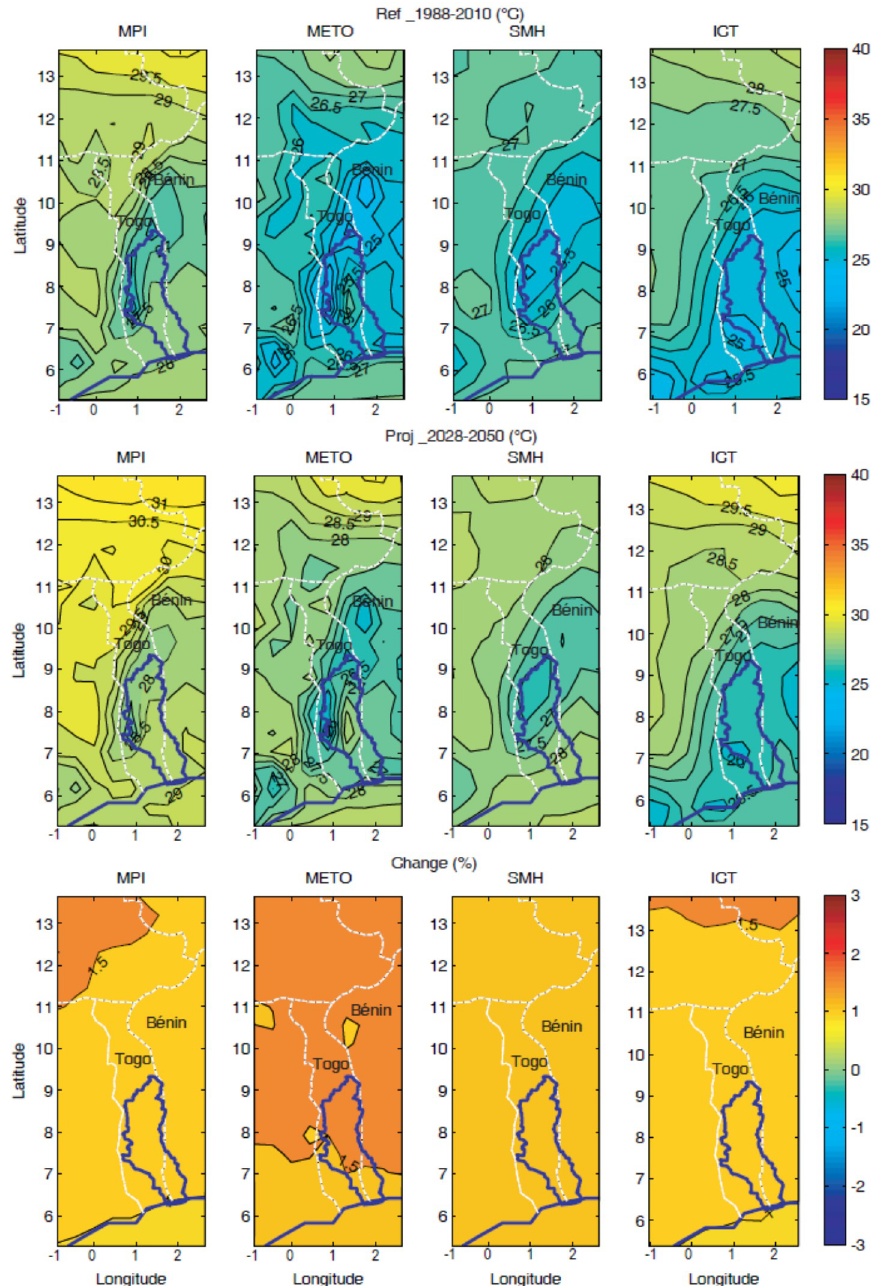
Figure 5. Spatial variation of the annual mean air temperature in the Mono river basin and surrounding areas as simulated by the four RCMs. Up: 1988–2010 reference period (in ◦ C); Middle: 2028–2050 projection period (in ◦ C); Down: variation between the reference and projection periods.